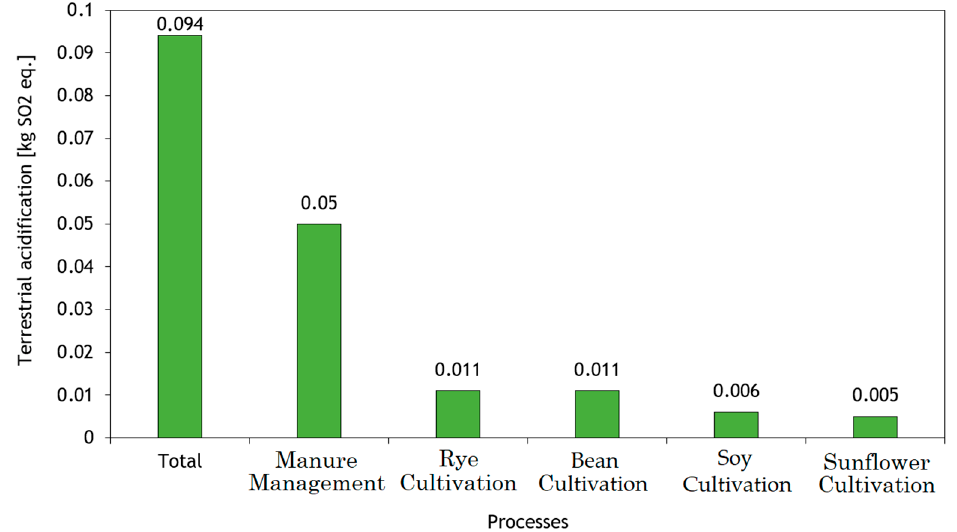
Figure 6. Terrestrial acidification results associated with each sub-system of the production of 1 kg of